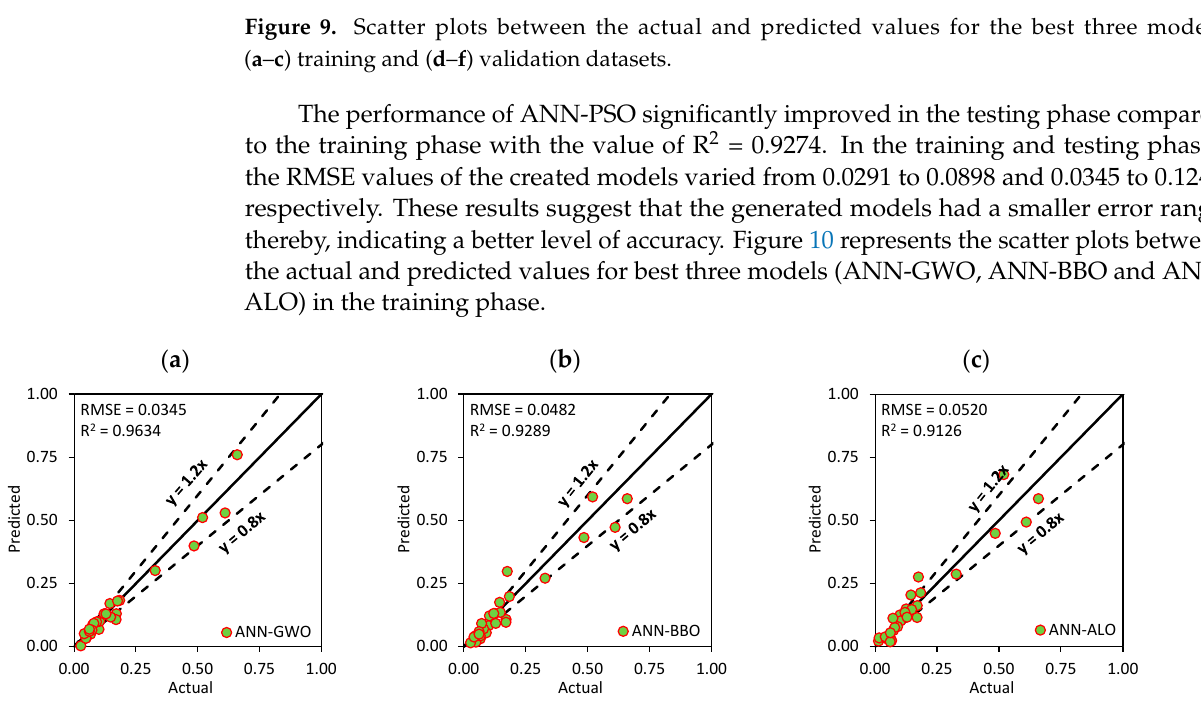
Figure 10. Scatter plots ( a – c ) between the actual and predicted values (for best three models—testing phase).